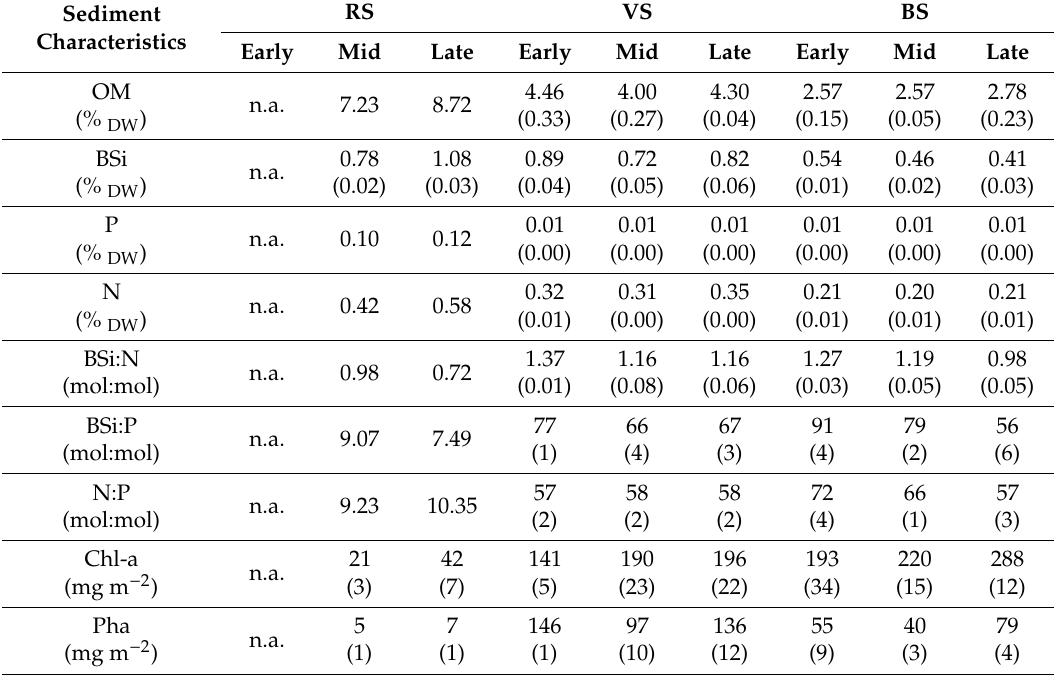
Table 3. Content of organic matter (OM), biogenic silica (BSi), total nitrogen (N), organic phosphorous (P), chlorophyll a (Chl-a), and phaeopigments (Pha) and BSi:N, BSi:P and N:P molar ratios in sediment at the three investigated sites (RS = rocky shores; VS = vegetated sediments; BS = bare sediments). All data represents the mean ± standard error (standard error in parenthesis), n.a. = not